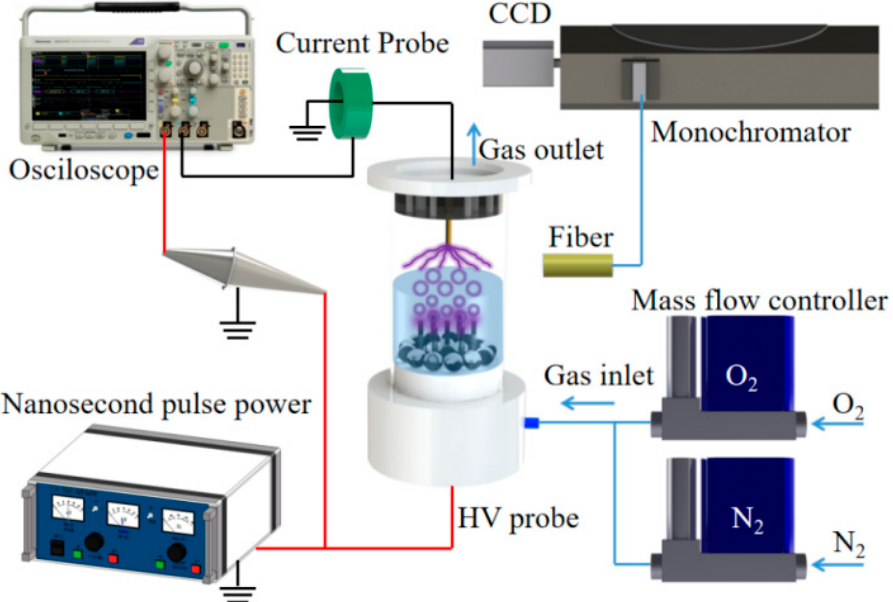
Figure 1. Schematic diagram of the experimental setup for PYR degradation in an NPG-LD reactor.